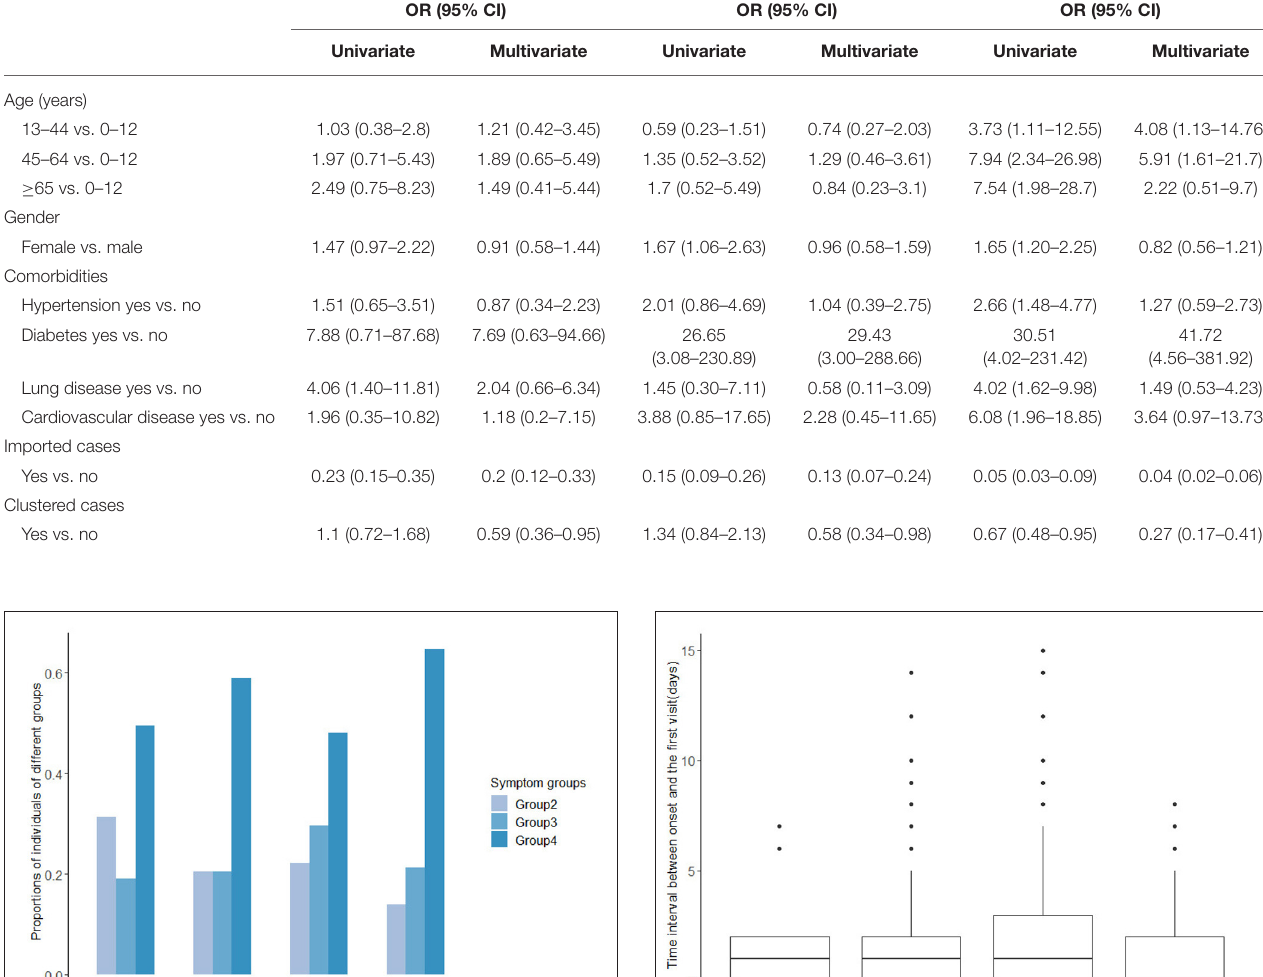
TABLE 2 | Results of population characteristics of different symptom groups. OR (95% CI) OR (95% CI) OR (95% CI) Univariate Multivariate Univariate Multivariate Univariate Multivariate